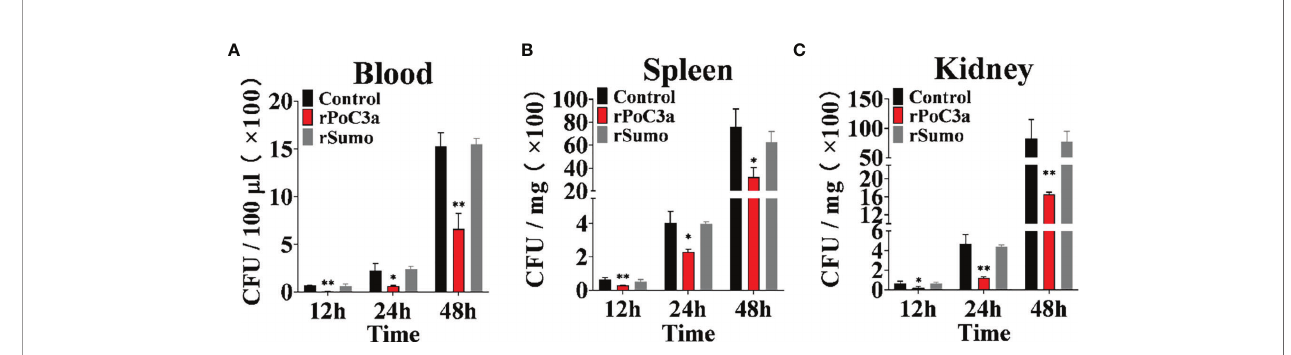
FIGURE 9 | Effects of rPoC3a on bacterial infection. Japanese fl ounder pre-administered with or without (control) rPoC3a or rSumo were infected with Edwardsiella tarda , and bacterial numbers in blood (A) , spleen (B) and kidney (C) were determined at various time points. Data are shown as means ± SEM (N = 3). N, the number of times the experiment was performed. *P < 0.05, **P